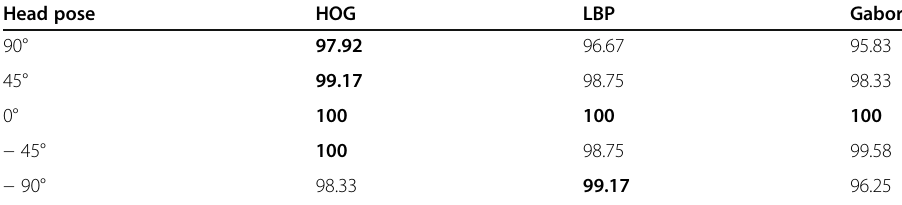
Table 2 Recognition rates (%) for person-dependent facial expression recognition. The best recognition rates are highlighted in bold Head pose HOG LBP Gabor 90° 97.92 96.67 95.83 45° 99.17 98.75 98.33 0° 100 100 100 − 45° 100 98.75 99.58 − 90° 98.33 99.17